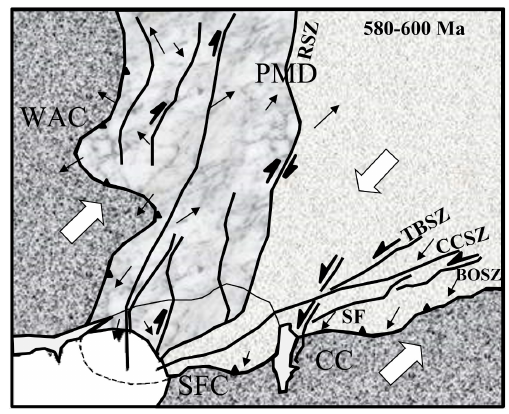
Figure 14. The Pan-African mobile domain (PMD) between the West African Craton (WAC) and the São Francisco (SFC) and Congo (CC) cratons showing two sub-domains, west and east, sep- arated by the Raghane shear zone (RSZ). Horizontal lines repre- sent the Tcholliré–Banyo shear zone (TBSZ), central Cameroon shear zone (CCSZ), Sanaga fault (SF), and Bétaré-Oya shear zone (BOSZ). Small arrows correspond to stretching lineations and large arrows to movement directions of blocks during D3 (600–580Ma). Modified from Toteu et al. (2004) (original document is available in the public